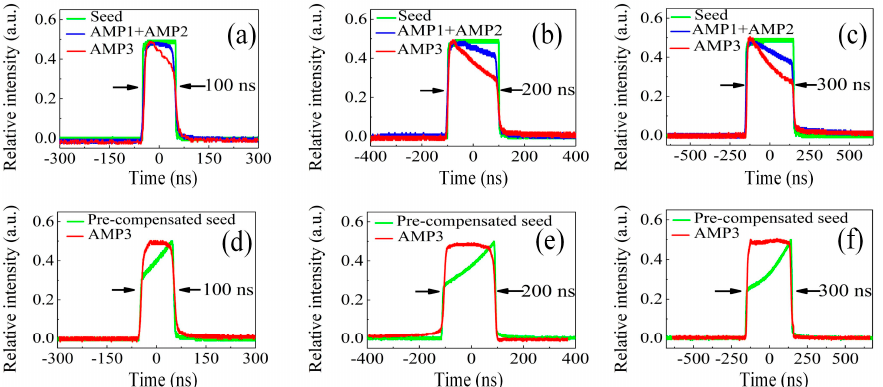
Figure 6. Recorded input and output pulse profile for pulse durations of 100 ns, 200 ns, and 300 ns. ( a – c ): Output profile of flat-top input at different amplification stages; ( d – f ): Input and output of pre-shaped flat-top profile.